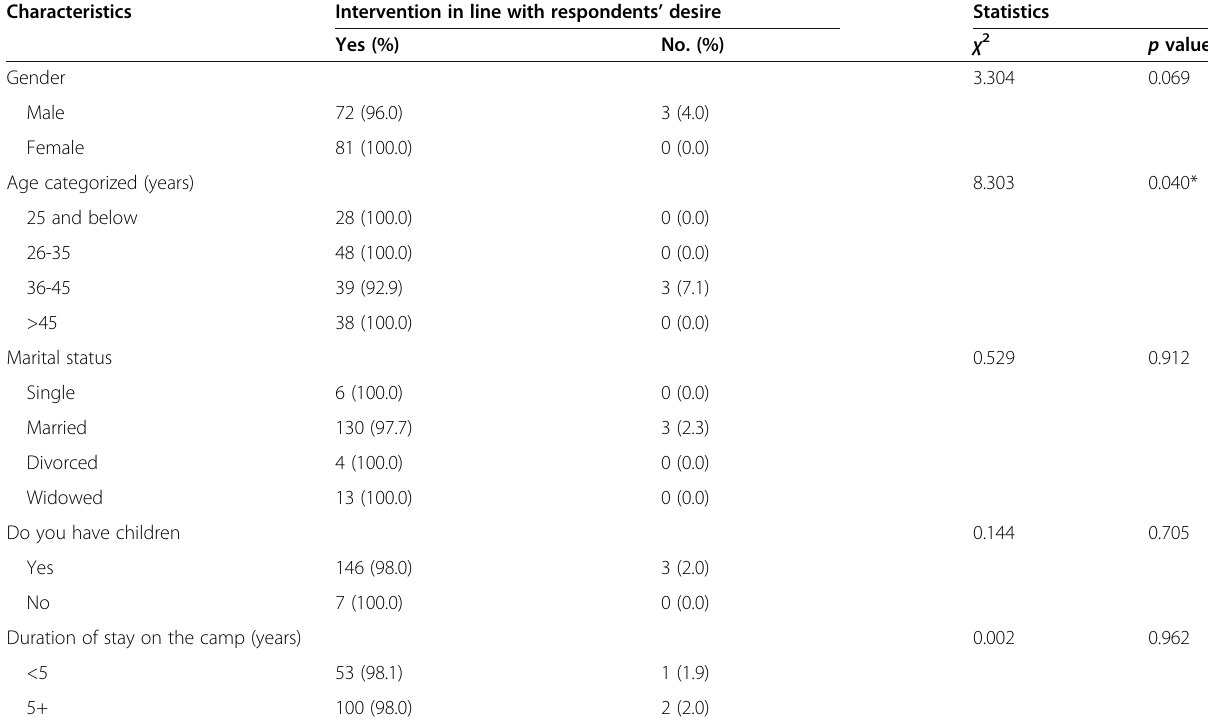
Table 5 Beneficiaries who were informed about the intervention and satisfaction with the intervention ( n =156) Characteristics Intervention in line with respondents ’ desire